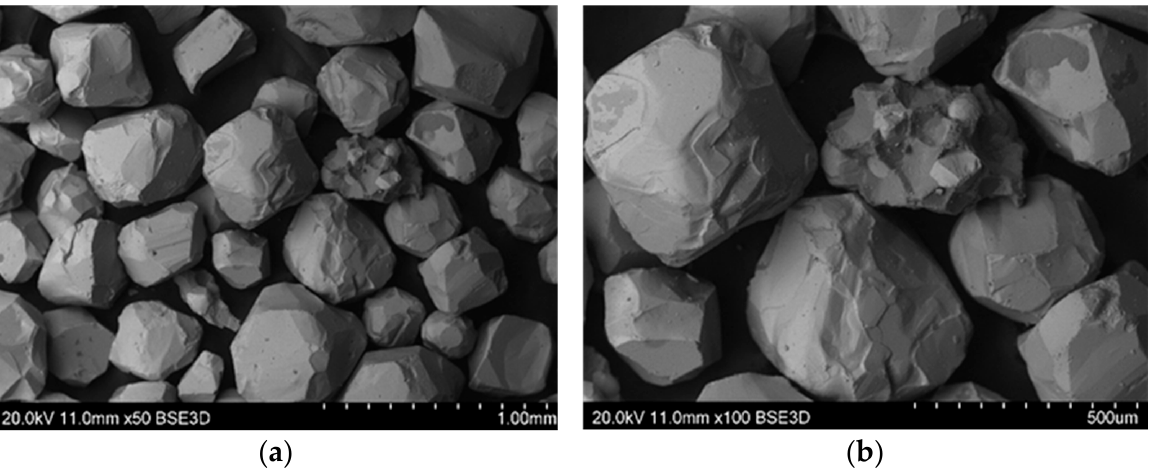
Figure 15. BSD images from the scanning electron microscope of the P100 chromite grain matrix: ( a ) mag. 50×, ( b ) mag. 100×.